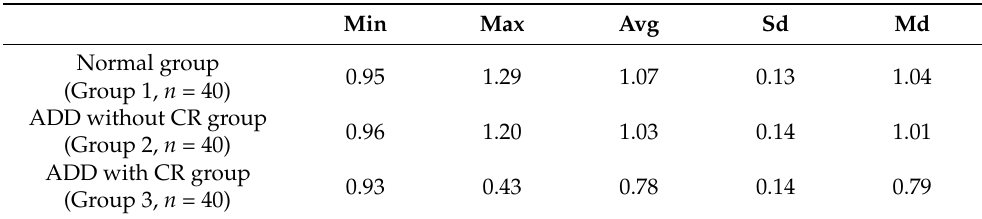
Table 2. SIR values in the three groups.